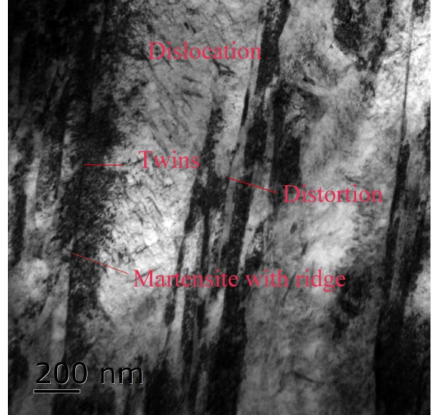
Figure 13. Acicular martensite with